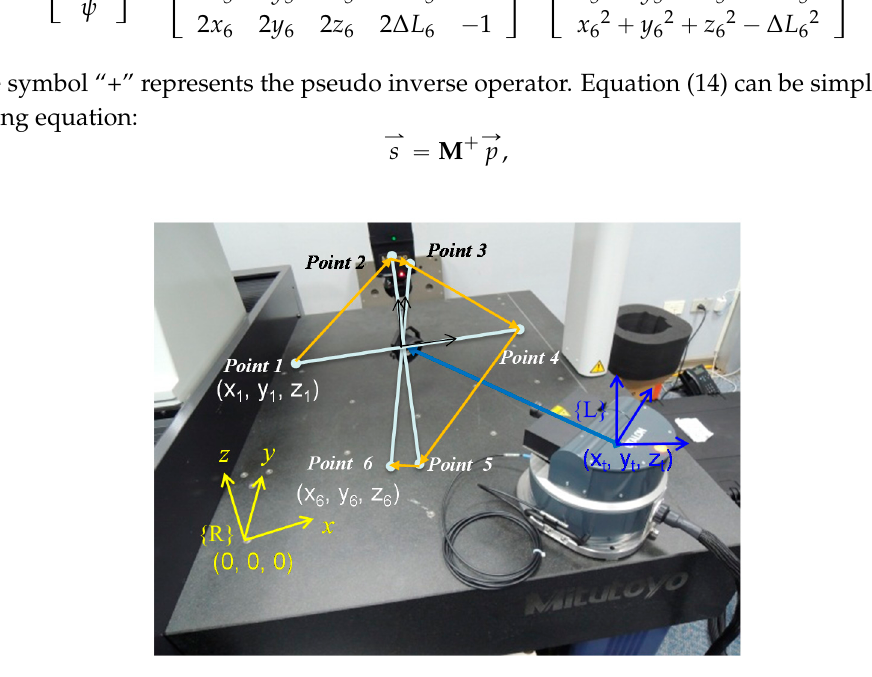
Figure 10. The coordinate of the LaserTRACER located on the machine is determined by six-point measurement, in which {R} represents the reference coordinate system ( i.e. , the reference point); {L} represents the coordinate system of the LaserTRACER; and {T} represents the coordinate system of the cat ′ s eye reflector.